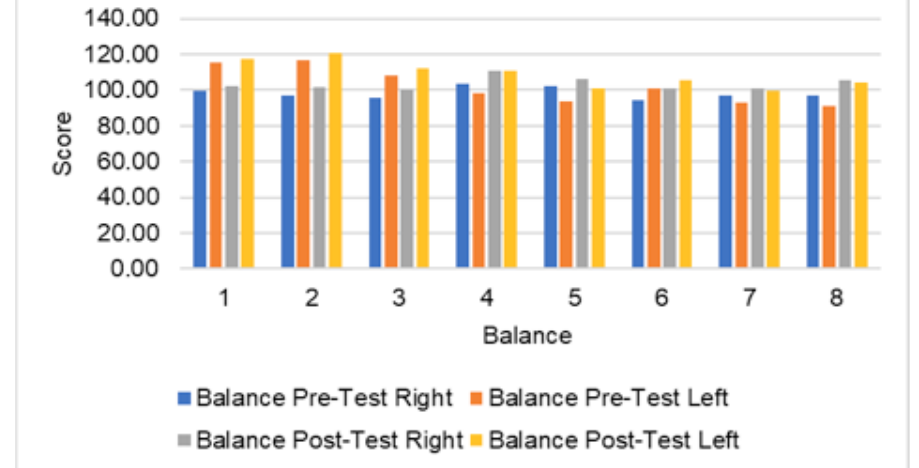
Figure 9. Data of balance bosu ball exercise 18 years old